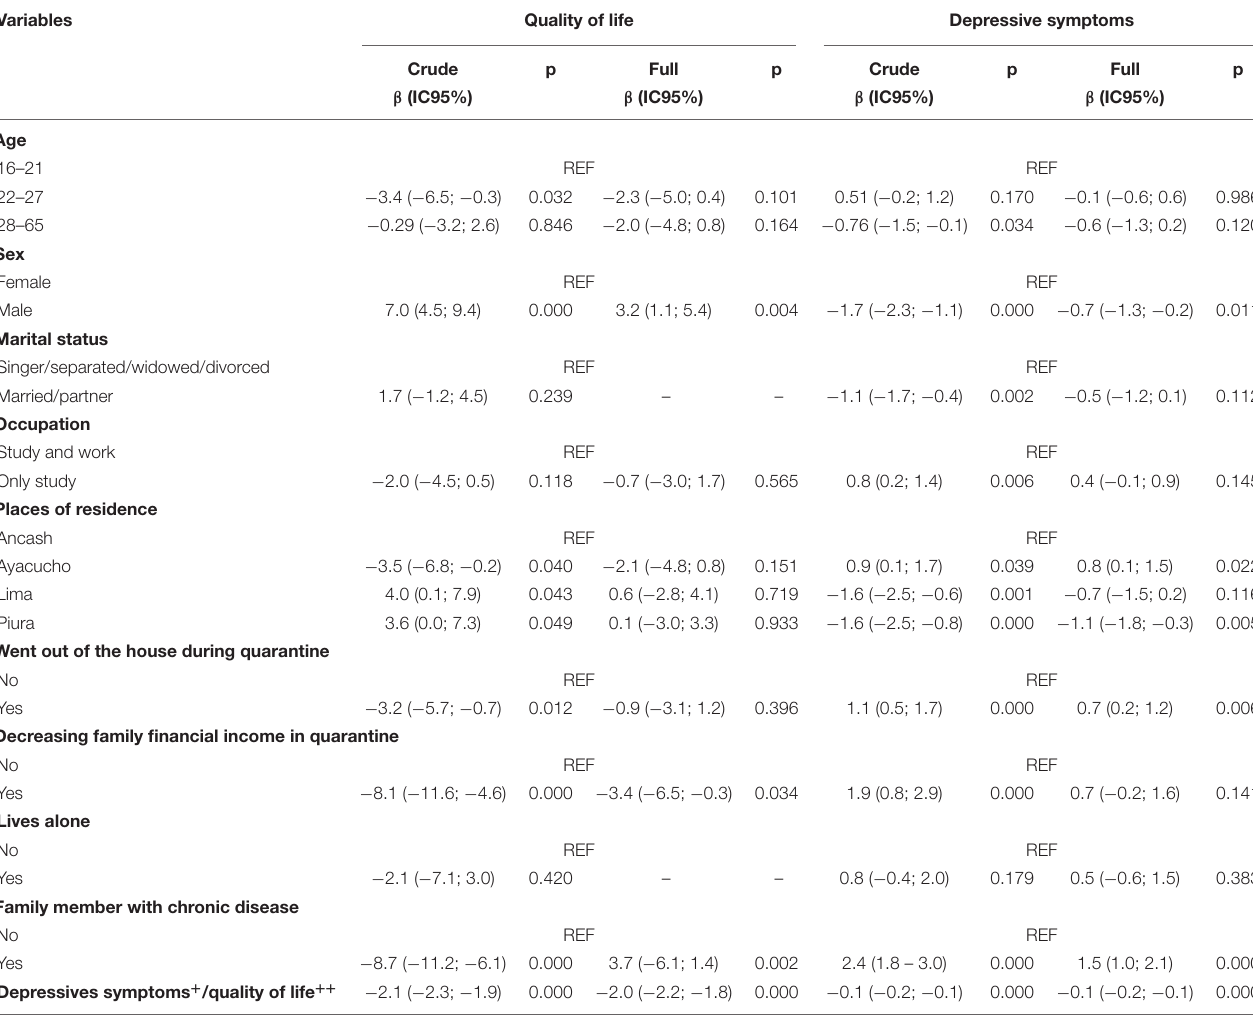
TABLE 4 | Factors associated with quality of life and depressive symptoms in Peruvian university students during the COVID-19 pandemic. Variables Quality of life Depressive